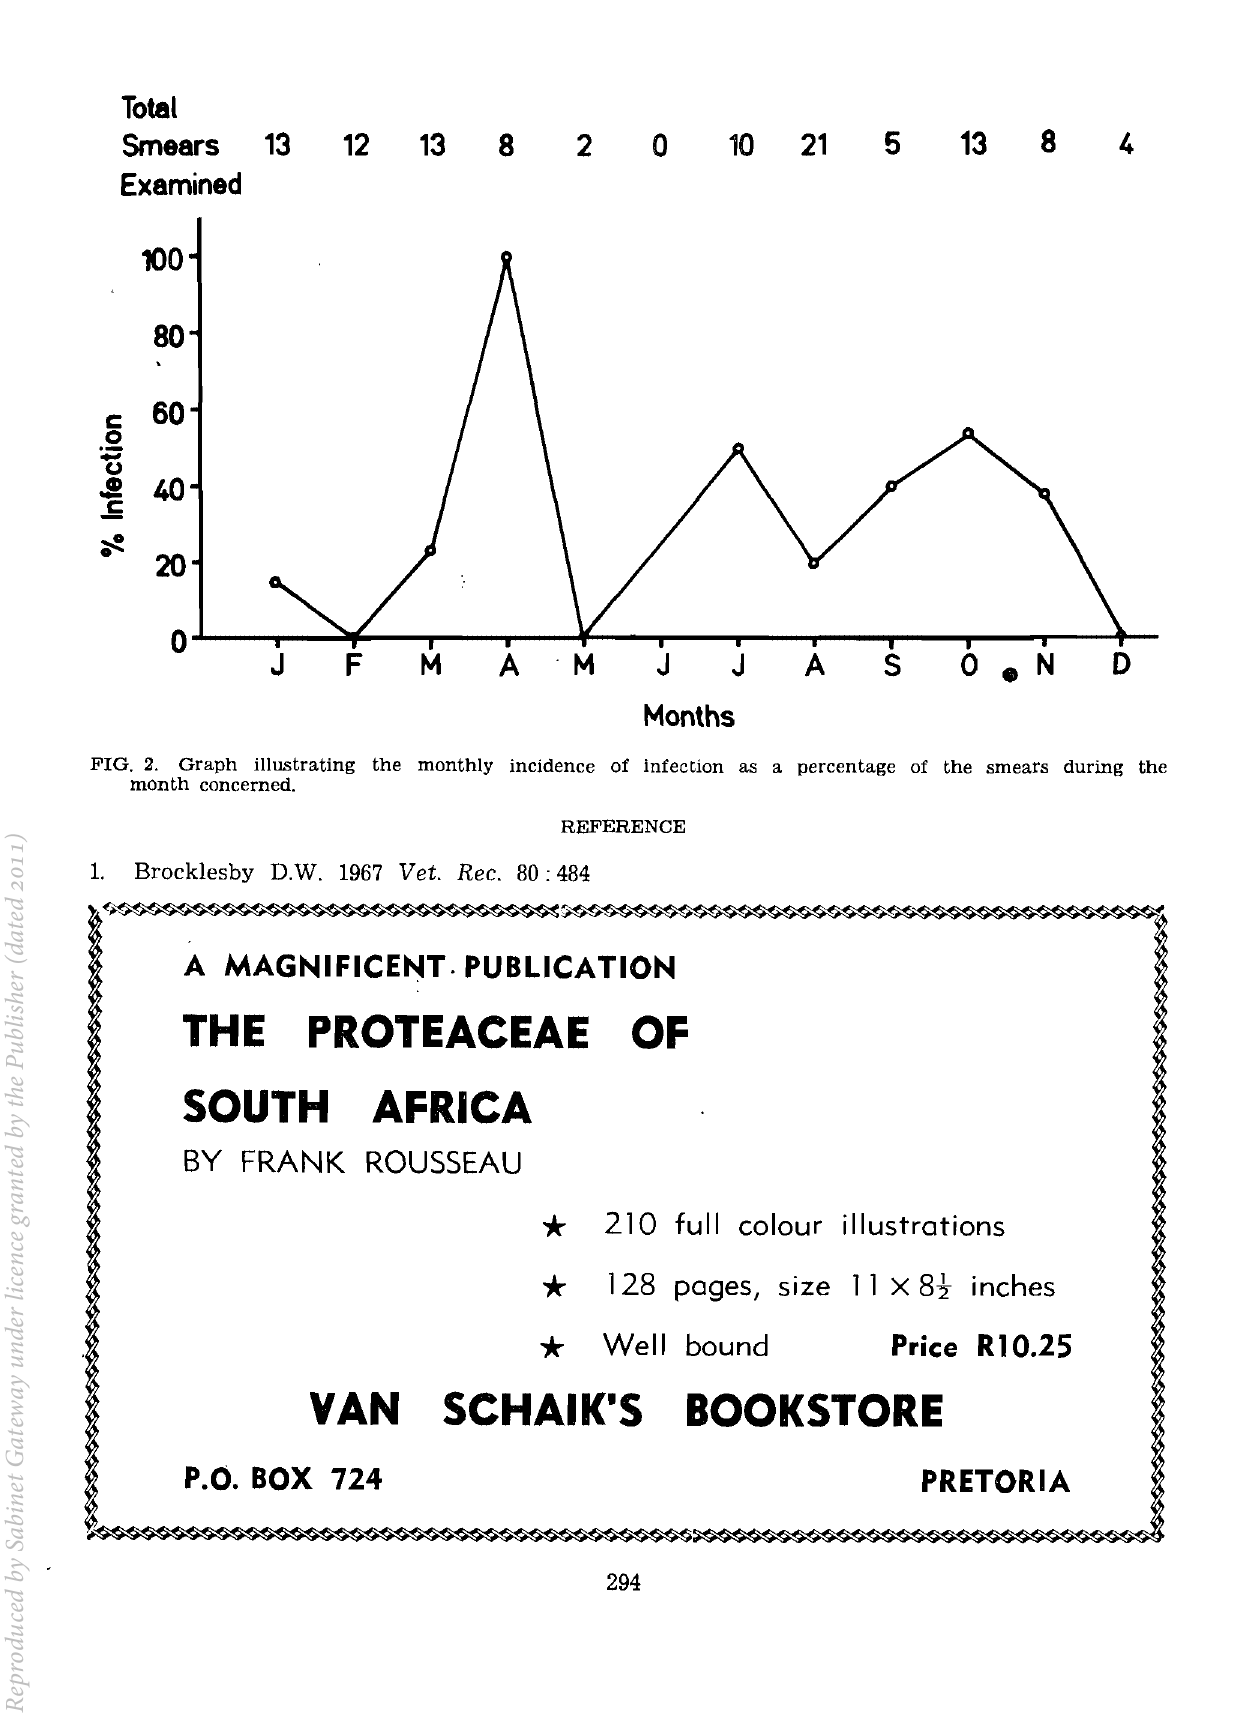
FIG. 2. Graph illustrating the monthly incidence of infection as a percentage of the smears during the month concerned.